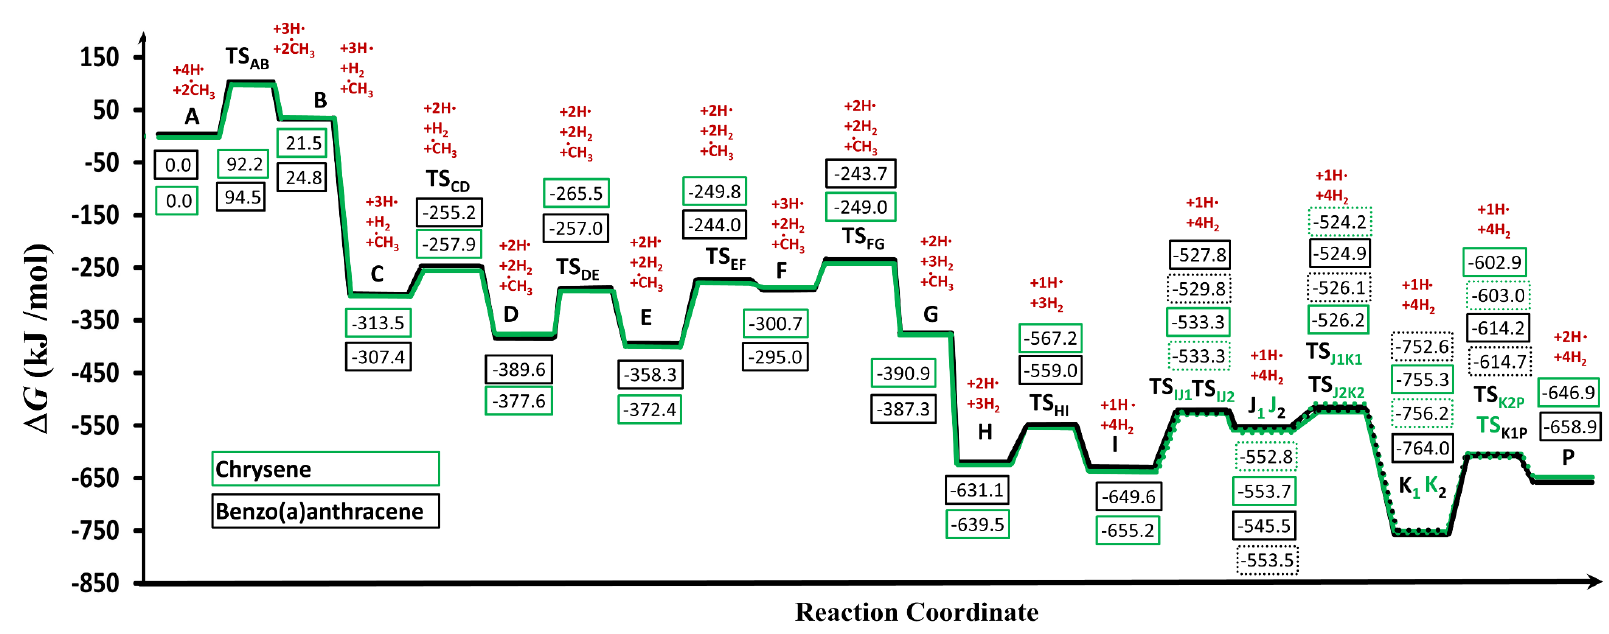
Figure 4. Gibbs free energy profile of the two reaction pathways leading to the formation of benzo(a)pyrene (BaP, P ) calculated at the M06-2X/6-311++G(d,p) level of theory using a fine-tuned integration grid (99 radial shells and 974 angular points per shell). The two reaction pathways are indicated by green and black (solid/dotted) lines, in the case of chrysene and benzo(a)anthracene, respectively.